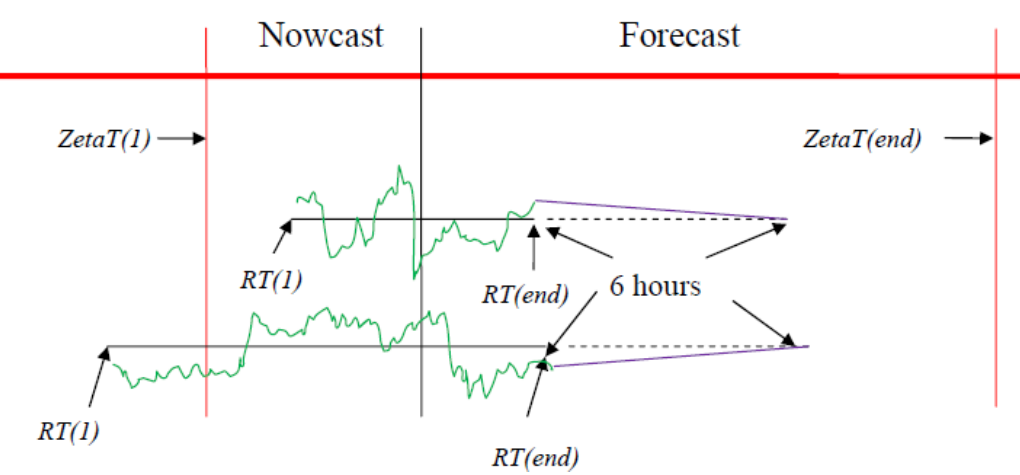
Figure 7. Diagram on how measured river stage height is used in